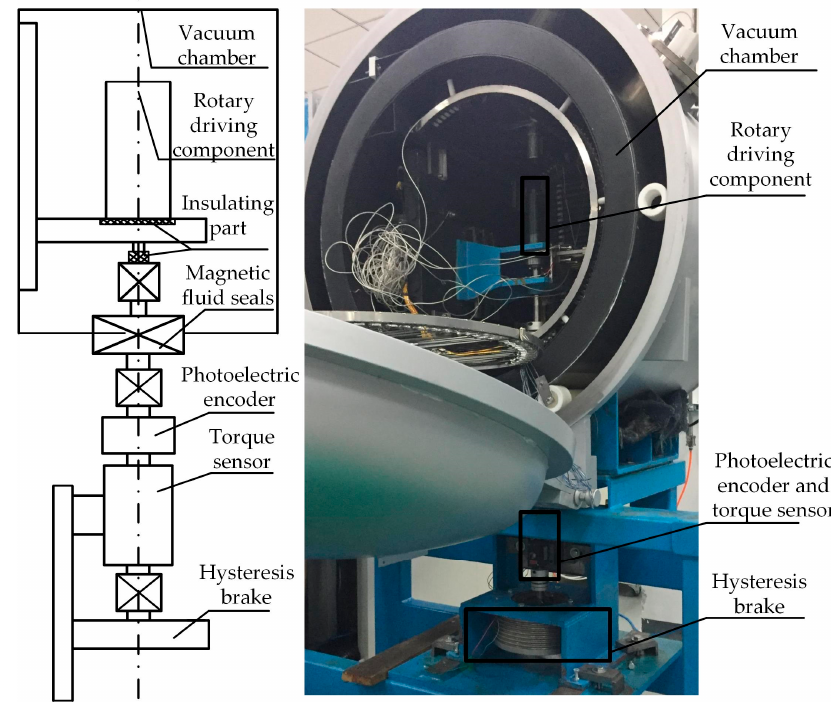
Figure 7. Vacuum test platform.